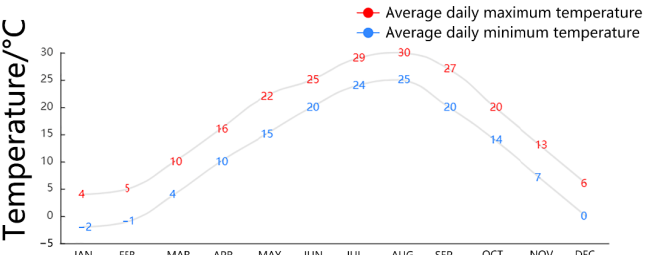
Figure 2. The meteorological analysis chart of monthly average temperature in Qingdao in 2021 (the meteorological information is cited from the Qingdao Meteorological